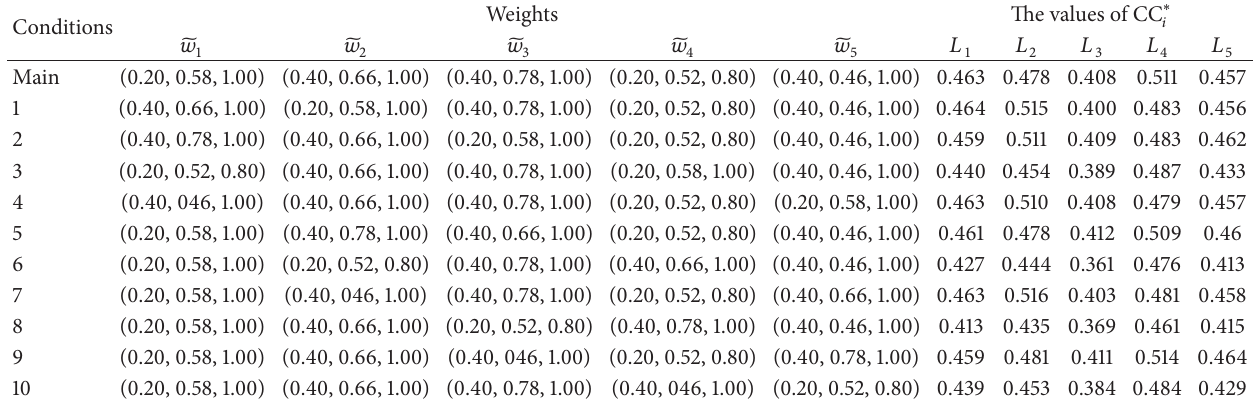
Table 11: Sensitivity analysis for location.